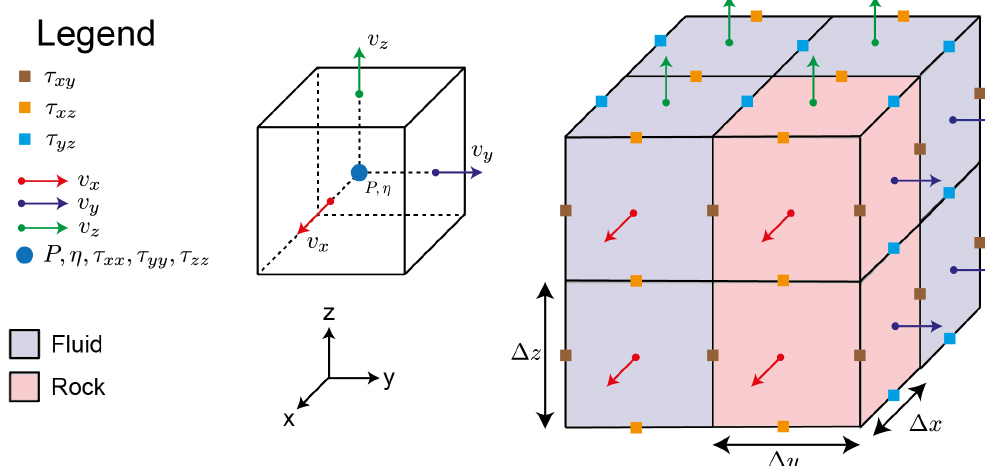
Figure 1. Staggered grid and location of